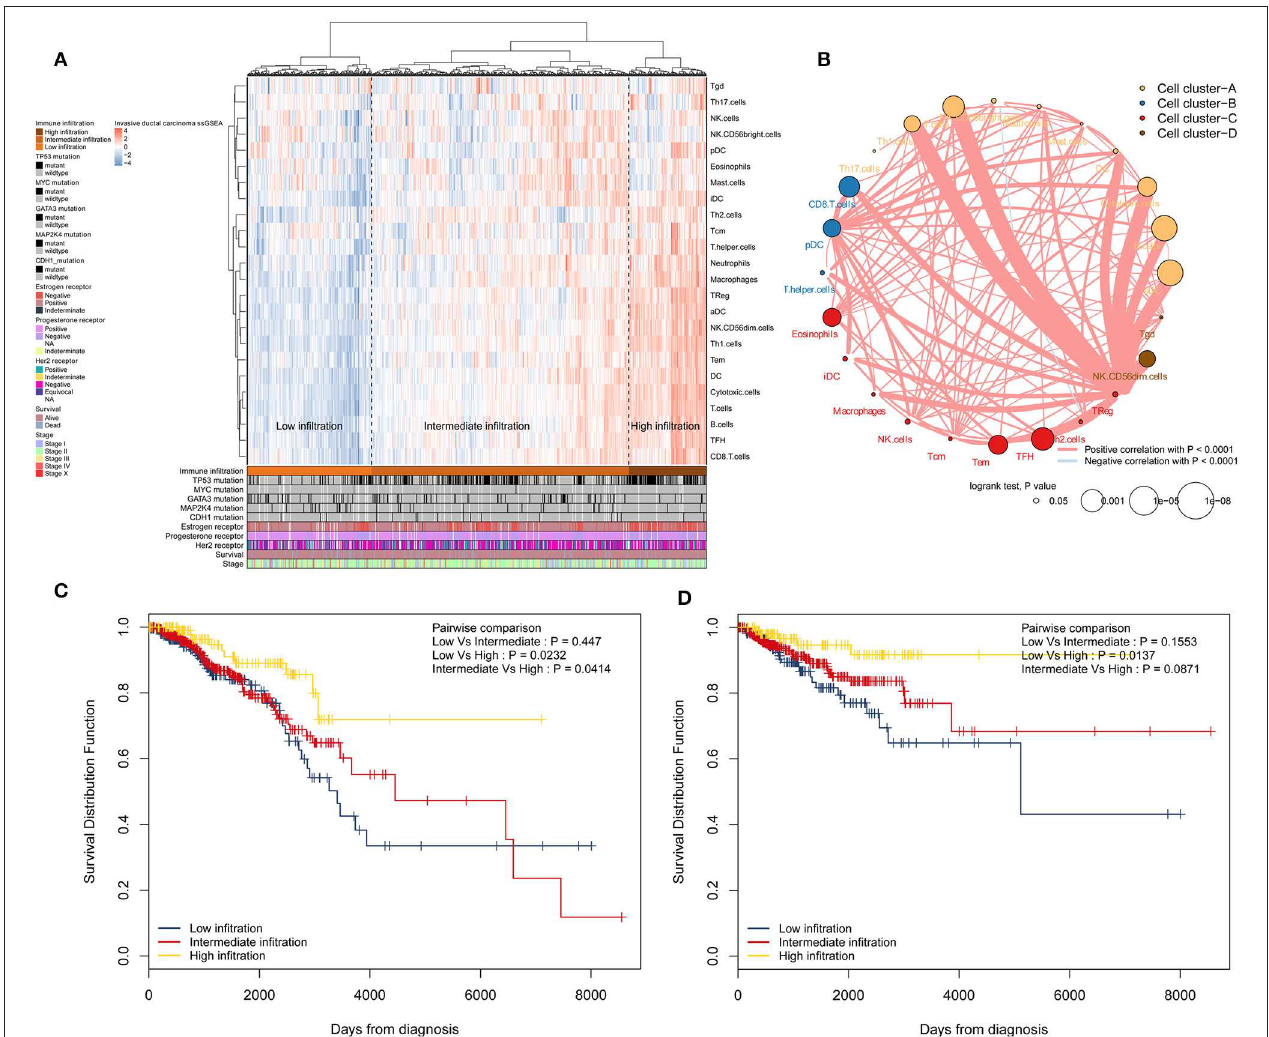
FIGURE 1 | Immune landscape of IDCs and the TME characteristics. (A) Unsupervised clustering of IDC patients from the TCGA cohort using ssGSEA scores from immune cell types. Mutation status of TP53, MYC, GATA3, MAP2K4, and CDH1, status of the estrogen receptor, status of the progesterone receptor, status of Her2, survival, and stage are shown as patient annotations in the lower panel. Hierarchical clustering was performed with Euclidean distance and Ward linkage. Three distinct immune infiltration clusters, here termed high infiltration, median infiltration, and low infiltration, were defined. (B) Interaction of the TME immune cell types. The size of each term represents the survival impact of each TME cell type, calculated by log 10 (log-rank test P -value). The connection of TME immune cells represents interactions between both. The thickness of the line indicates the strength of the correlation calculated by Spearman correlation analysis. Positive correlations are represented in red, and negative correlations are represented in blue. The immune cell cluster was clustered by the hclust method. Immune cell cluster-A, yellow; cell cluster-B, blue; cell cluster-C, red; and cell cluster-D, brown. (C) Kaplan-Meier curves for OS of IDC patients showing that the high immune infiltration group had a favorable outcome compared with the other groups. (D) Kaplan-Meier curves for RFS of IDC patients showing that the high immune infiltration group had a favorable outcome compared with other groups. IDC, invasive ductal carcinoma; TME, tumor microenvironment; TCGA, The Cancer Genome Atlas; OS, overall survival; RFS, recurrence-free